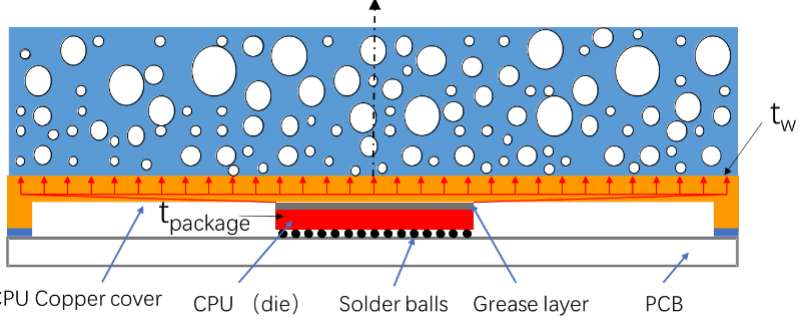
Figure 6. CPU structure and boiling heat exchange schematic.